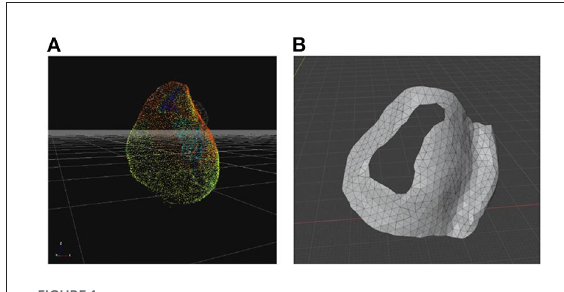
FIGURE1 3D models for surgical guide printing. (A) Photogrammetric reconstruction view in Zephir software scatter point; (B) Tool model in Blender software.